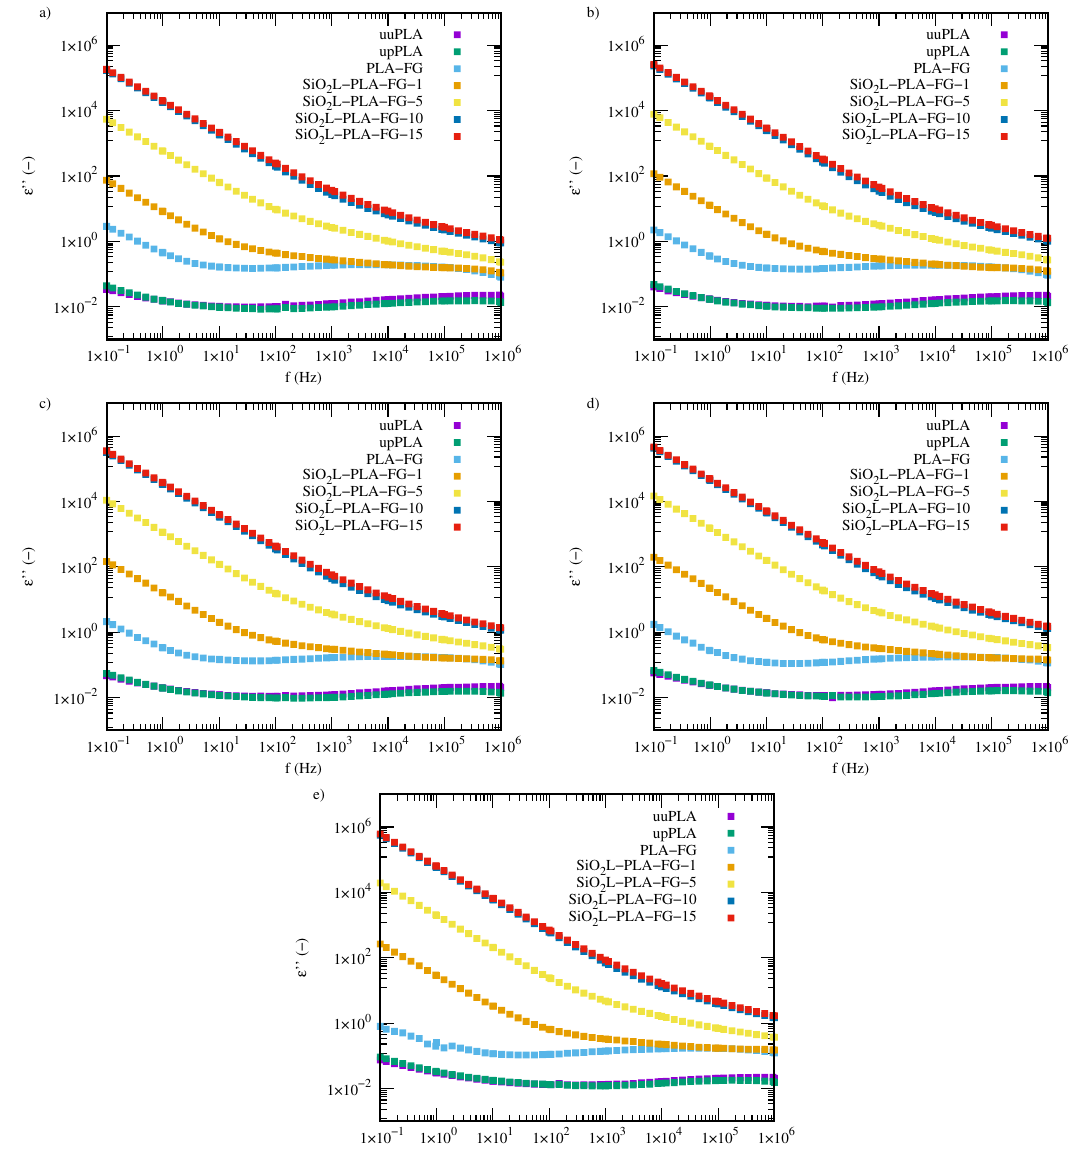
Figure A3. The imaginary part of the complex permittivity of silicon-dioxide–lignin nanocomposites as a function of frequency for ( a ) 298.15 K, ( b ) 303.15 K, ( c ) 308.15 K, ( d ) 313.15 K, and ( e ) 318.15